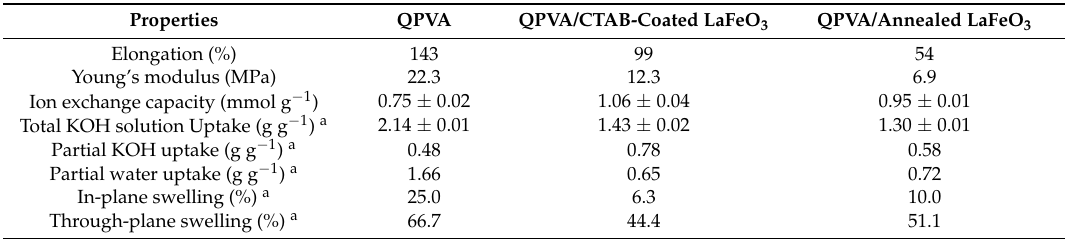
Table 1. Mechanical strength, ion-exchange capacity, total KOH uptake, and swelling ratio of pristine QPVA, QPVA/0.1%CTAB-coated LaFeO 3 , and QPVA/0.1% annealed LaFeO 3 nanocomposite